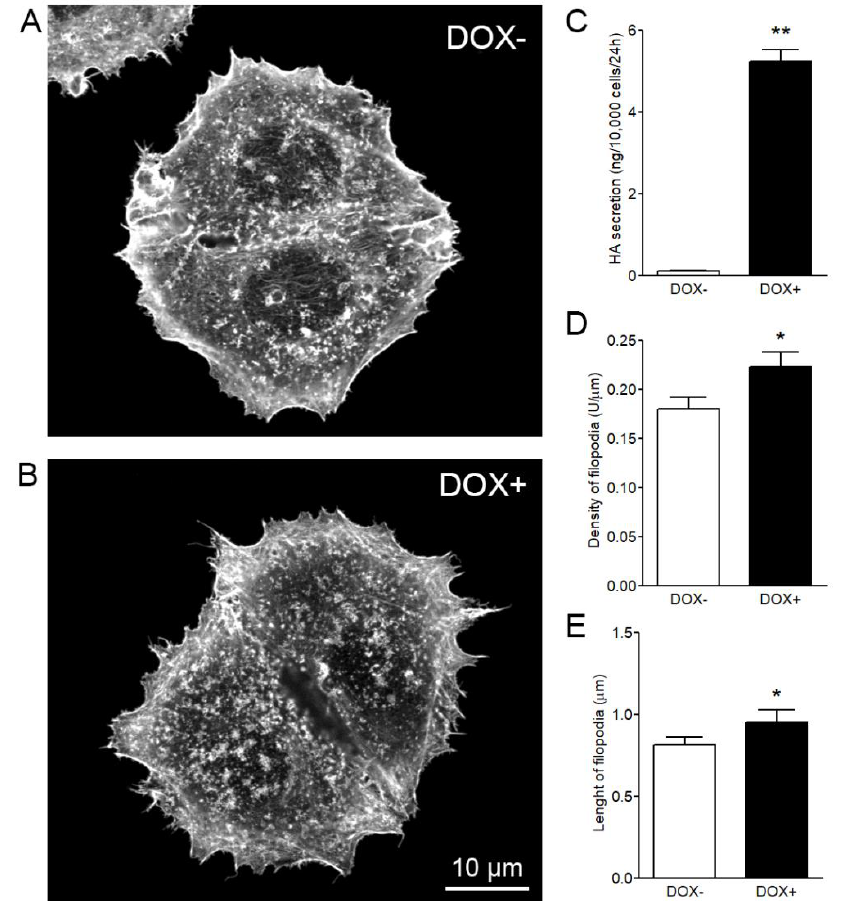
Figure 3. Analysis of stable MCF-7 cells with inducible expression of GFP-HAS3 in fixed and phalloidin-stained cells. Examples of analyzed cells ( A ) without and ( B ) with induction of GFP-HAS3 expression by doxycycline. ( C ) The levels of hyaluronan synthesis, ( D ) the average density, and ( E ) the average length of filopodia without and with induction. Student’s t -test, * p < 0.05. ** p < 0.01 ( n = 5 independent experiments with 16–28 cells / group in each experiment).